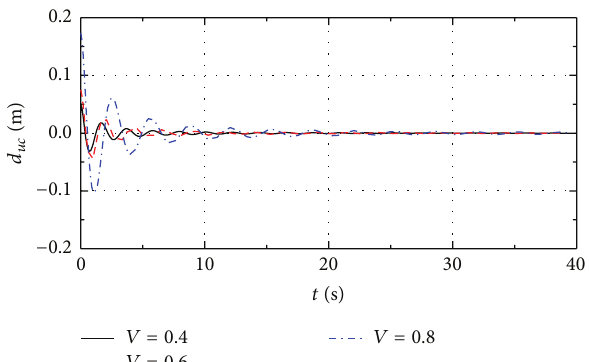
Figure 7: The difference between the analytical and asymptotical displacements of the contact point.